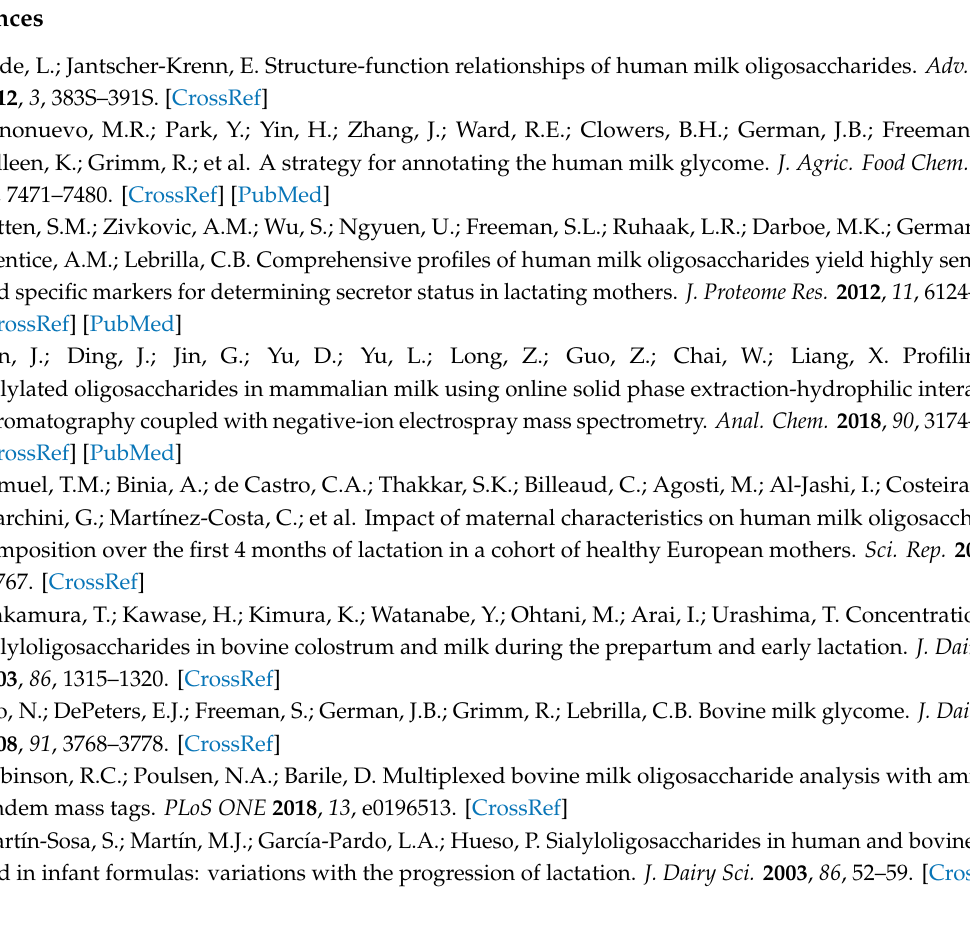
Figure S1: Growth curves of piglets fed formula containing various concentrations of 6 (cid:48) sialyllactose, Figure S2: Mean formula consumption containing various concentrations of 6 (cid:48) sialyllactose, Table S1: Body weight and absolute small intestinal weight and length and organ weights of piglets fed formula containing various concentrations of 6 (cid:48) -SL sodium salt., Table S2: pH of colonic and cecal contents of piglets fed formula containing various concentrations of 6 (cid:48) -SL sodium salt., Table S3: Serum minerals, electrolytes, metabolites, and proteins measured in the serum of piglets fed formula containing various concentrations of 6 (cid:48) -SL sodium salt on study day 8., Table S4: Enzymes, indicators of renal and liver function and acid:base balance measured in the serum of piglets fed formula containing various concentrations of 6 (cid:48) -SL sodium salt on study day 8., Table S5: Serum minerals, electrolytes, metabolites, and proteins measured in the serum of piglets fed formula containing various concentrations of 6 (cid:48) -SL sodium salt on study day 22., Table S6: Enzymes, indicators of renal and liver function and acid:base balance measured in the serum of piglets fed formula containing various concentrations of 6 (cid:48) -SL sodium salt on study day 22., Table S7: Complete blood count and di ff erential analysis measured in the serum of piglets fed formula containing various concentrations of 6 (cid:48) -SL sodium salt on study 8., Table S8: Complete blood count and di ff erential analysis measured in the serum of piglets fed formula containing various concentrations of 6 (cid:48) -SL sodium salt on study 22., Table S9: Number of urine samples (% total) containing any glucose, blood, white blood cells, red blood cells and epithelial cells, bacteria and crystals in piglets fed formula containing various concentrations of 6 (cid:48) -SL sodium salt on study